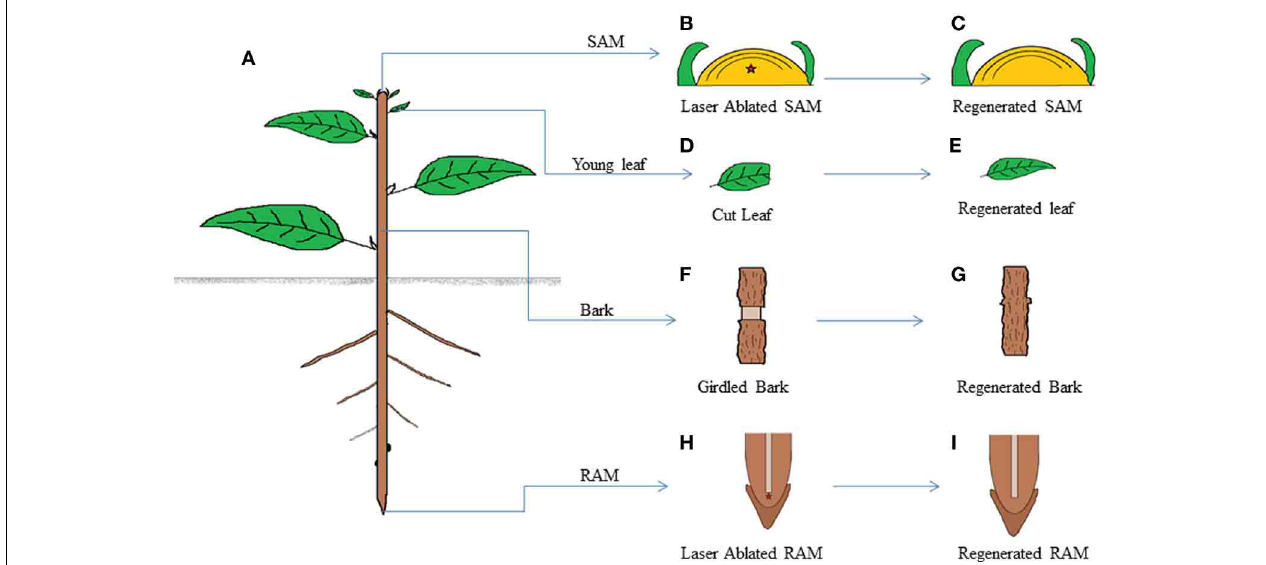
FIGURE 2 | Schematic drawing showing regeneration ability of various parts of a plant. A plant shows high levels of regeneration (A) . When SAM of the plant is laser ablated, (B) the wound gets regenerated without external